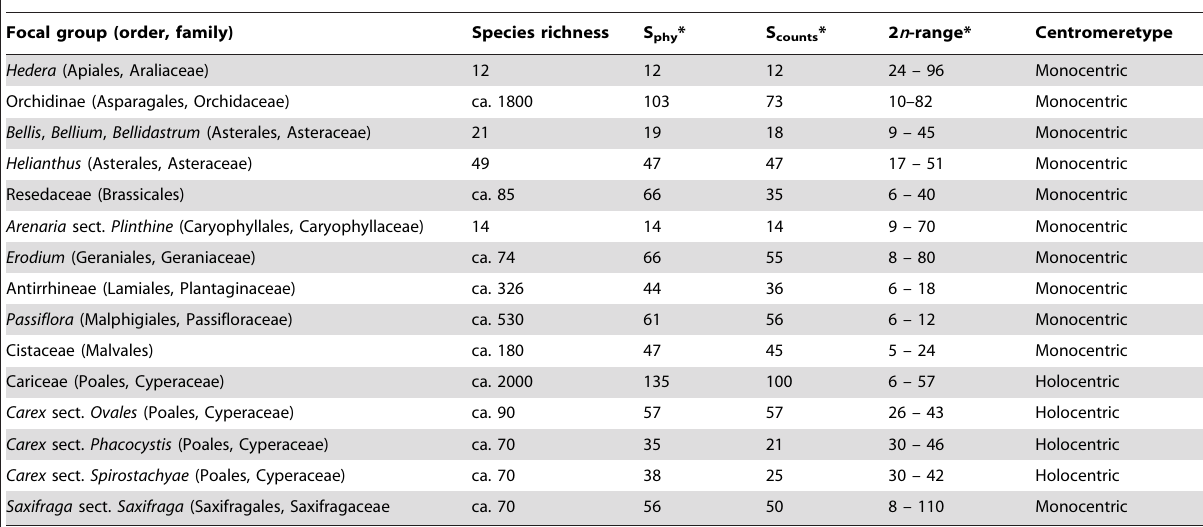
Table 1. Main features of the datasets analysed in this